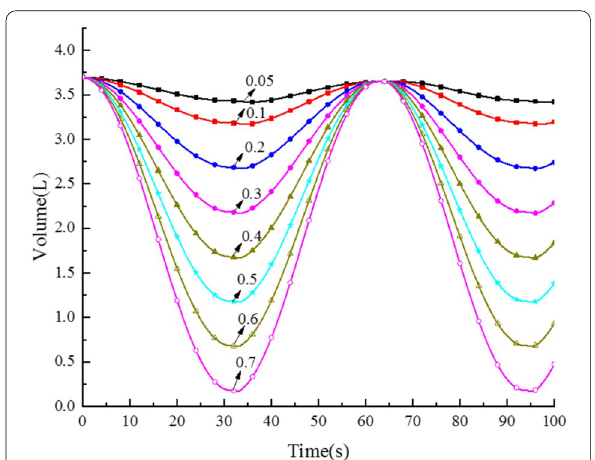
Figure 17 Changes in height at different